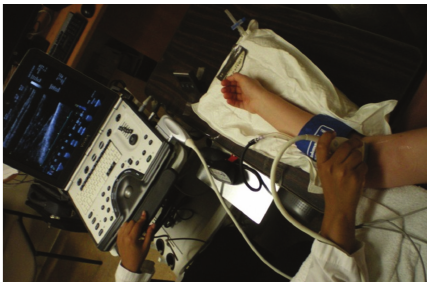
Figure 1: Setup of FMD studies showing proximal manual probe holding technique and distal cuff